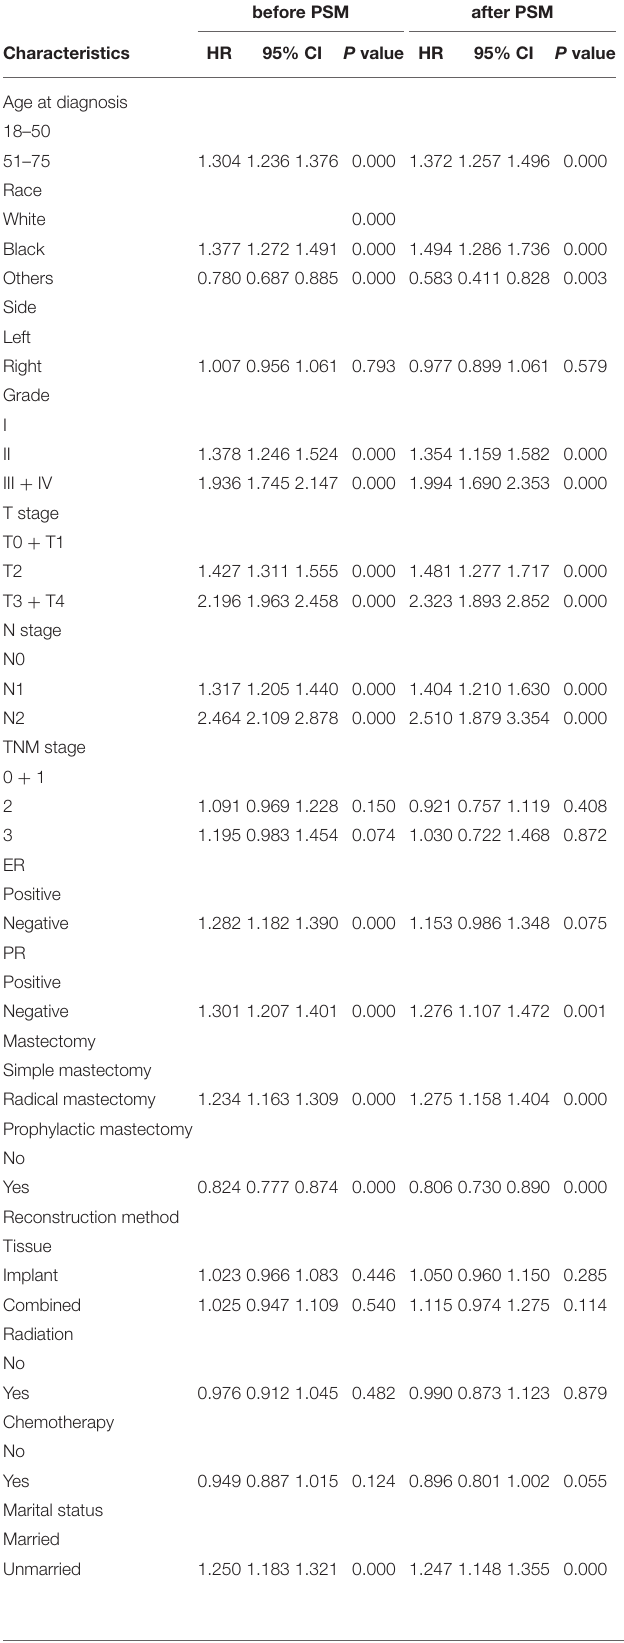
TABLE 2 | Multivariate Cox regression model analysis of